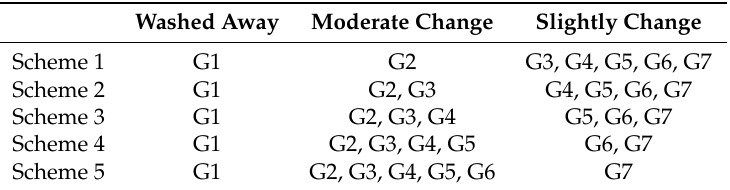
Table 4. Reclassification of MLIT’s